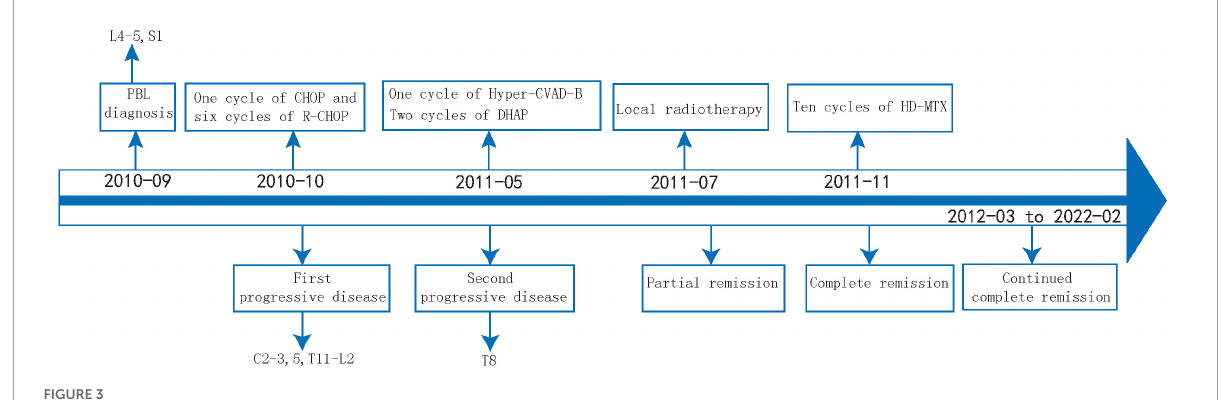
FIGURE3 Treatment timeline of the patient with